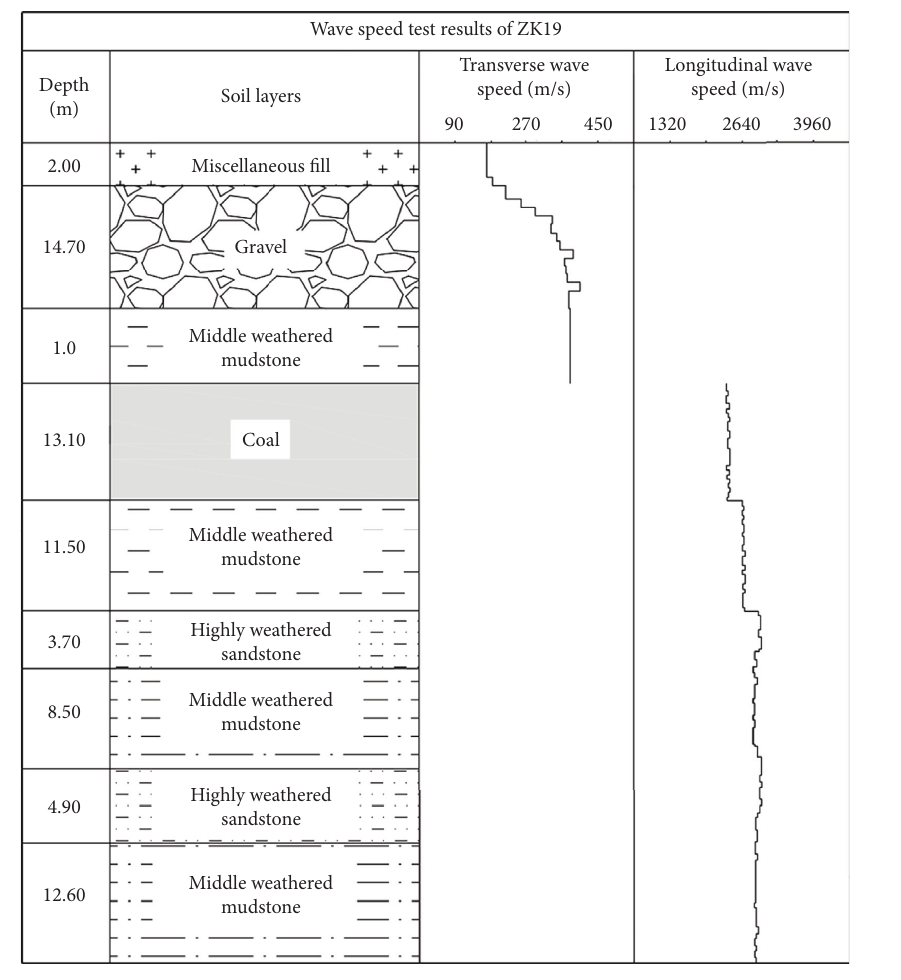
Figure 26: Wave speed test results of ZK19.